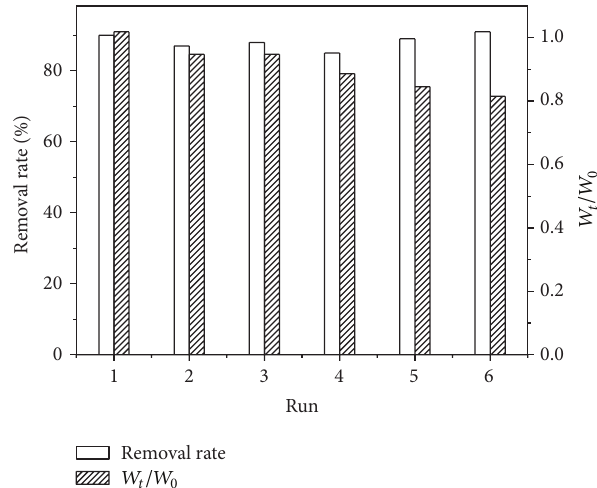
Figure 6: TiO 2 -Fe 3 O 4 -bentonite regeneration